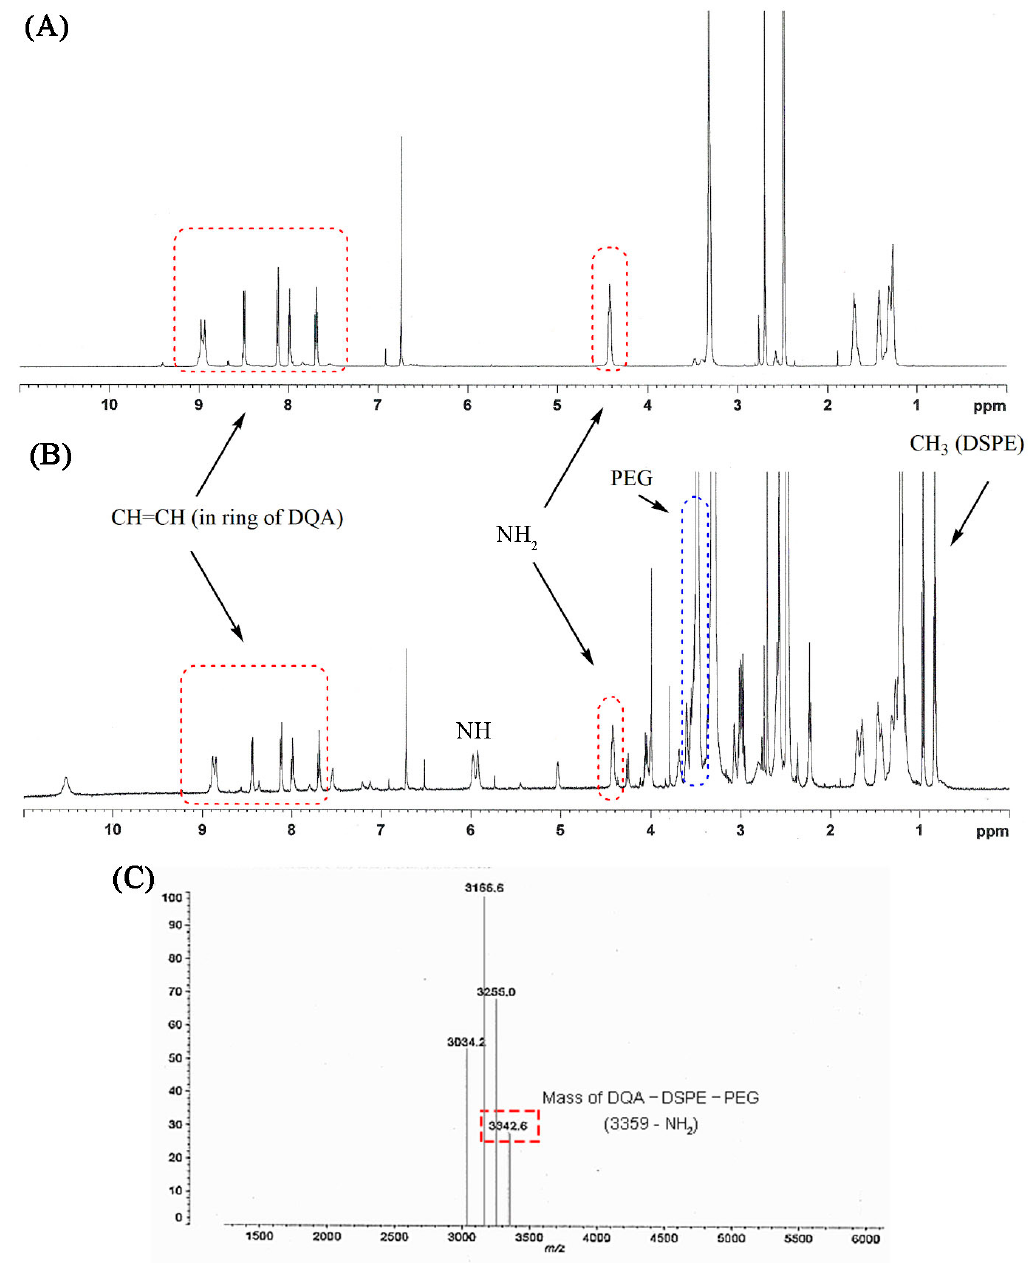
Figure 4. Proton NMR spectra of dequalinium (DQA) ( A ) and DQA-DSPE-PEG conjugate ( B ). ( C ) MALDI-TOF mass of DQA-DSPE-PEG.